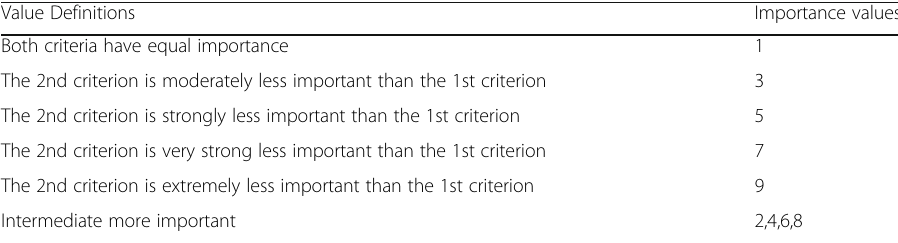
Table 5 Binary comparison scale Value